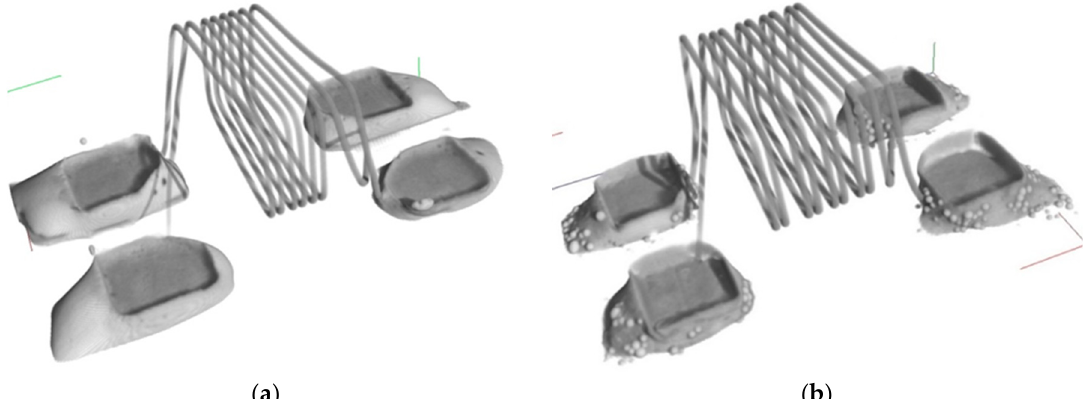
Figure 12. 3D CT scan of the component with ( a ) water washable solder paste and ( b ) with Sn nano reinforced powder water washable solder paste. reinforced powder water washable solder paste.